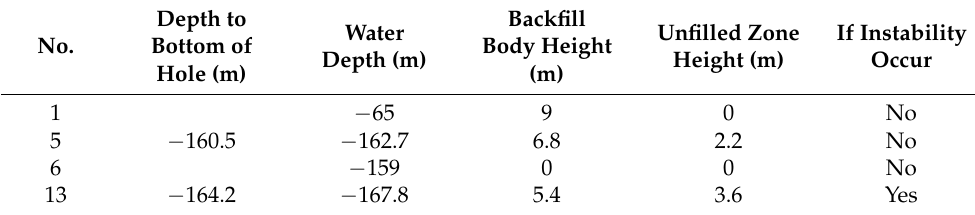
Table 9. Observations from different boreholes [30,31] .